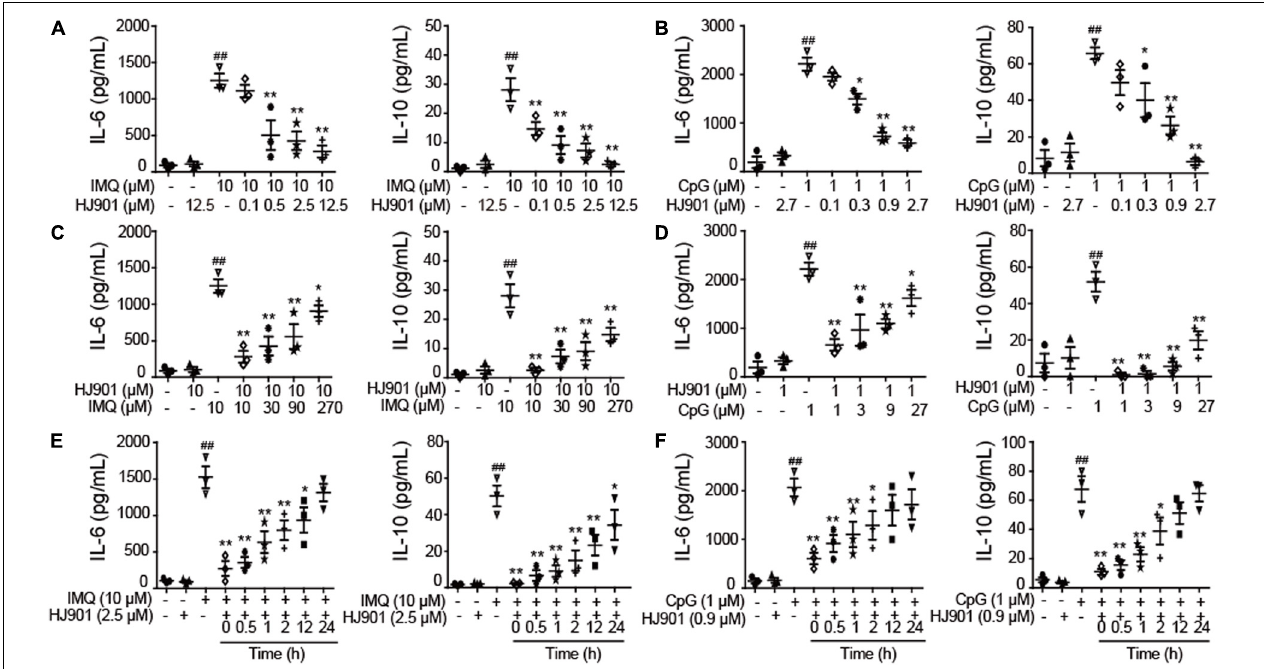
FIGURE 2 | Suppressive effect of HJ901 on TLR7/9-mediated cytokine production in human PBMCs. (A,B) Human PBMCs were cultured with 10 µ M IMQ or 1 µ M CpG in the presence or absence of different concentrations of HJ901 (0.1, 0.5, 2.5, or 12.5 µ M or 0.1, 0.3, 0.9, or 2.7 µ M) for 36 h. (C,D) Human PBMCs were cultured with HJ901 in the presence or absence of different concentrations of IMQ (10, 30, 90, or 270 µ M) or CpG (1, 3, 9, or 27 µ M) for 36 h. (E,F) Human PBMCs were incubated with 10 µ M IMQ or 1 µ M CpG for 0, 0.5, 1, 2, 12, or 24 h and then treated with or without HJ901 for 36 h. Supernatants were analyzed for IL-6 and IL-10 levels with a cytometric bead array (CBA). Similar results were obtained from three independent experiments. All data are presented as the means ± SEM ( n = 5 in each group). ## p < 0.01 vs. the untreated group or HJ901 group; * p < 0.05 and ** p < 0.01 vs. the IMQ or CpG